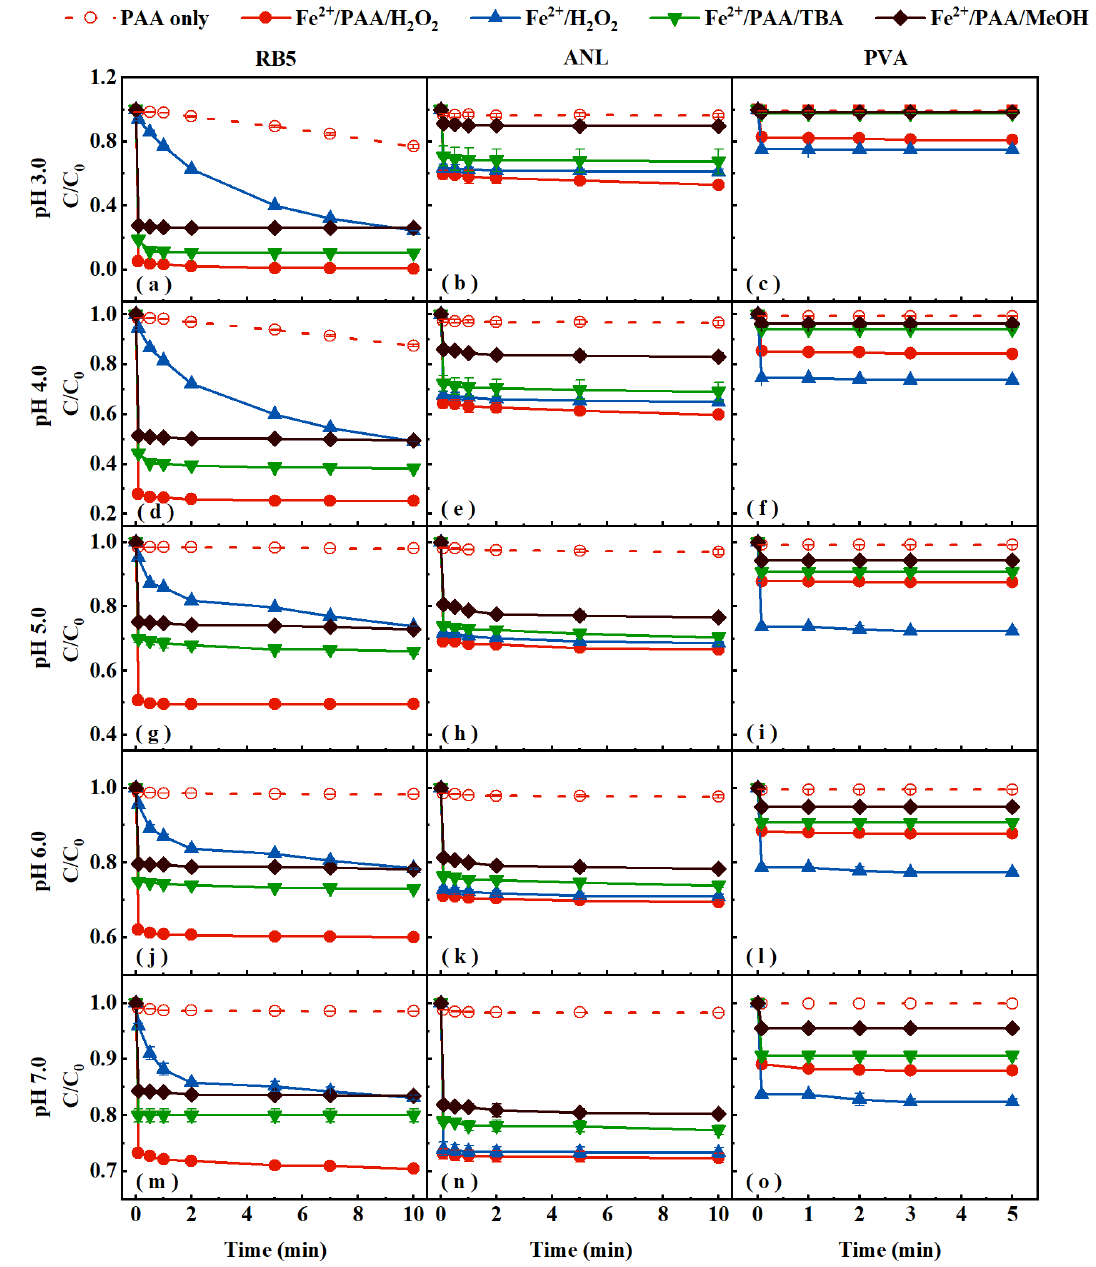
Figure 1. Time-dependent degradation of ( a , d , g , j , m ) RB5, ( b , e , h , k , n ) PVA and ( c , f , i , l , o ) ANL by different processes in a pH range of 3.0–7.0. Conditions: [PAA] 0 = 15 mg/L, [H 2 O 2 ] 0 = 5 mg/L, [RB5] 0